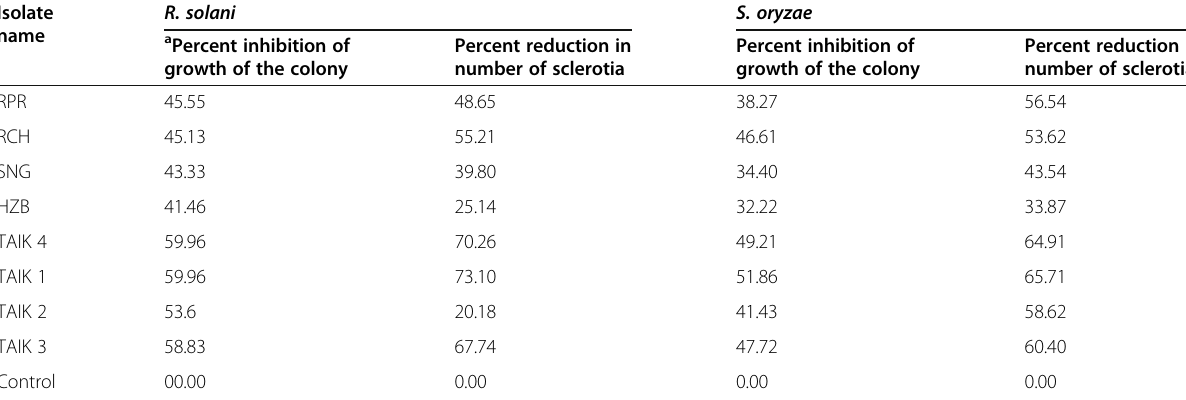
Table 2 Antagonistic efficacy of the different isolates of Trichoderma on R. solani and S.